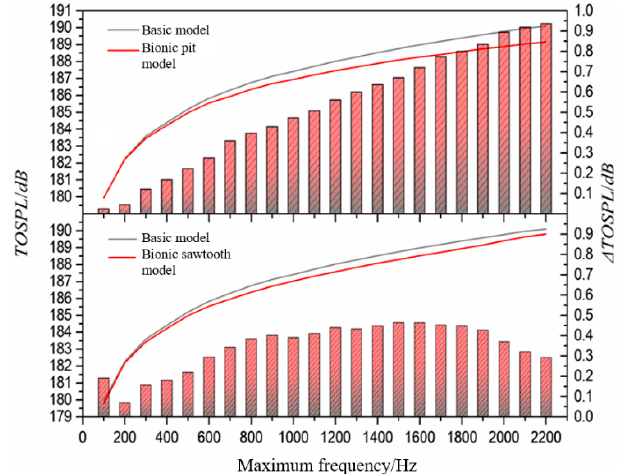
Figure 11. Relationship between noise reduction value and calculation frequency.